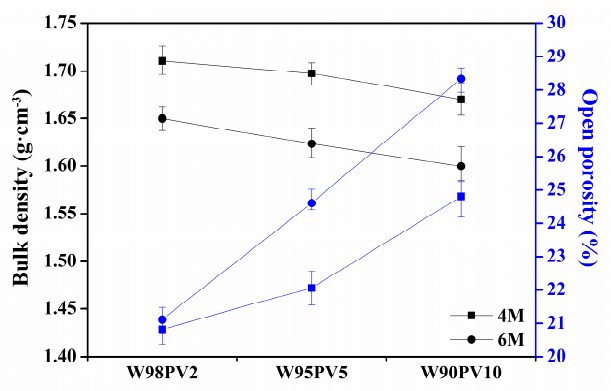
Figure 9. Bulk density and open porosity of AA-WBA/PV binders.